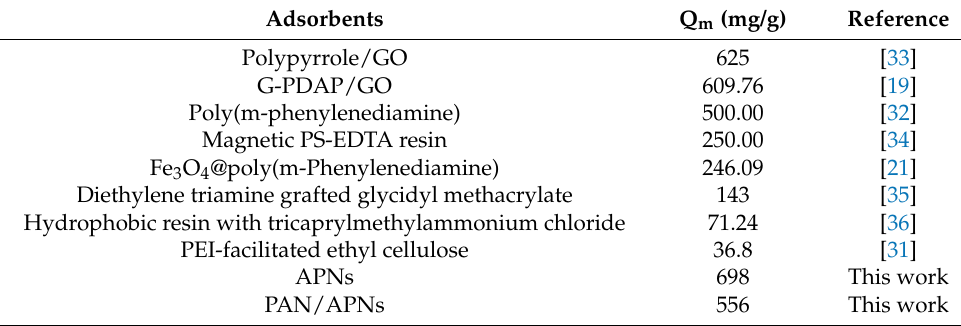
Table 1. The Q m values of APNs, PAN/APNs and other reported adsorbents.